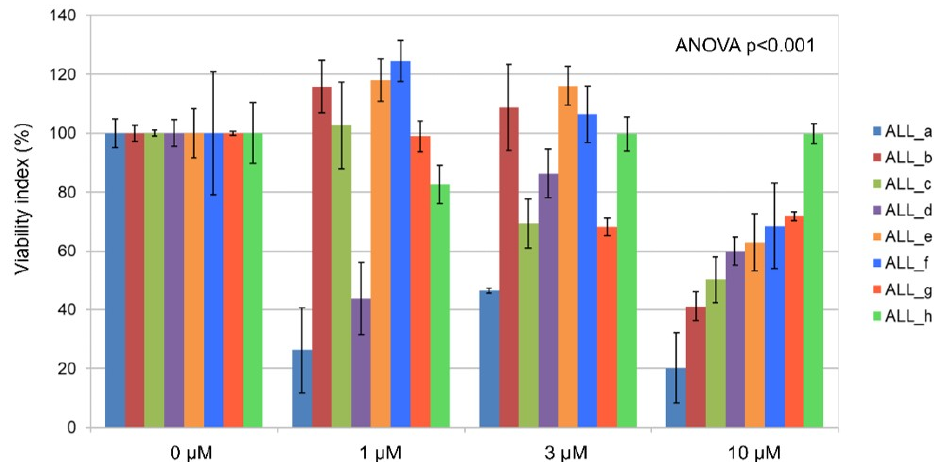
Figure 4. Ex vivo effects of imetelstat on primary B-ALL cells. Percentages of apoptosis in lym- phoblasts ( n = 8, ALL_a–h) treated ex vivo with different clinically relevant concentrations of imetel- stat compared to lymphoblasts from the same patients cultured without imetelstat. Each panel is the result of triplicate cell